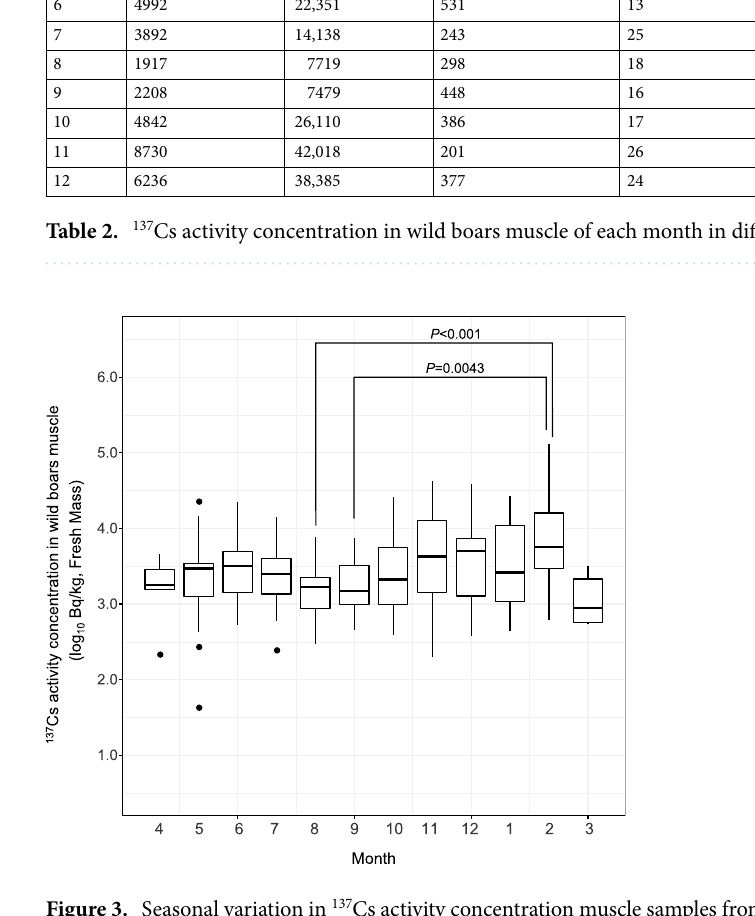
Figure 3. Seasonal variation in 137 Cs activity concentration muscle samples from wild boar inside the difficult- to-return-zone (DRZ). The upper part of the box plot shows the 75th percentile and the lower part shows the 25th percentile. The horizontal lines in the box indicate the median value. The whiskers above and below the boxes indicate the maximum and minimum values, respectively. Black dots indicate outliers. The P values were calculated using the Steel–Dwass test ( P < 0.01) between each